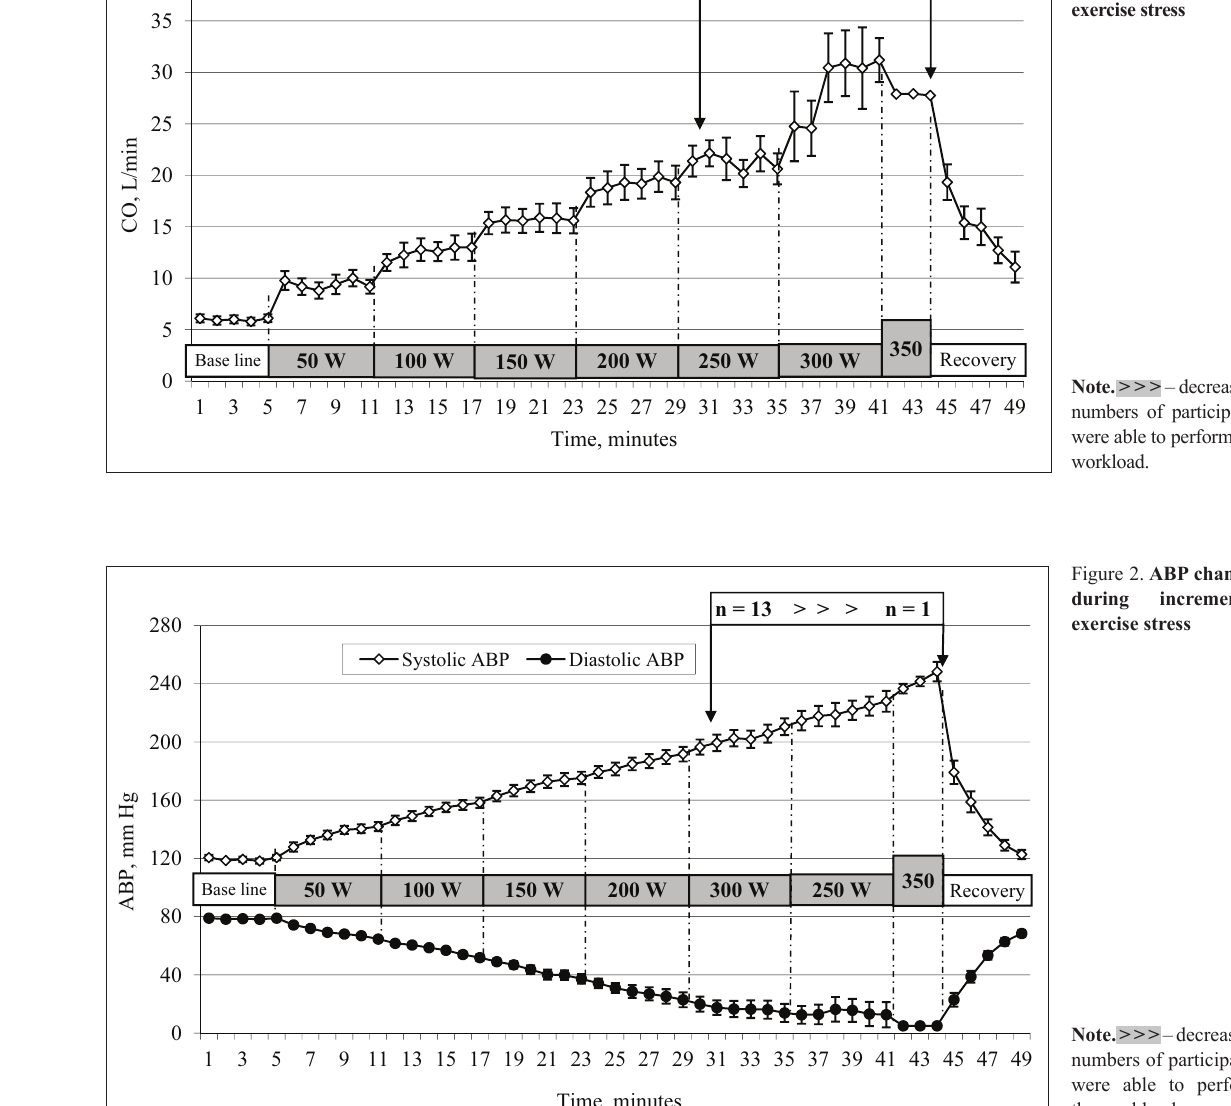
Figure 2. ABP changes during incremental exercise